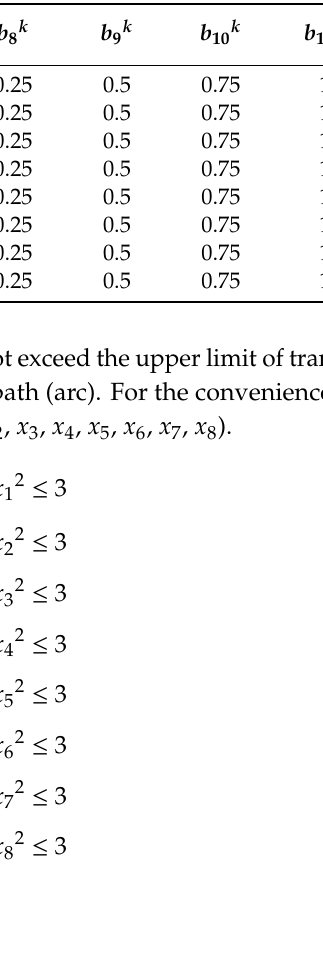
Table 18. Fuzzy function values of reliability for each